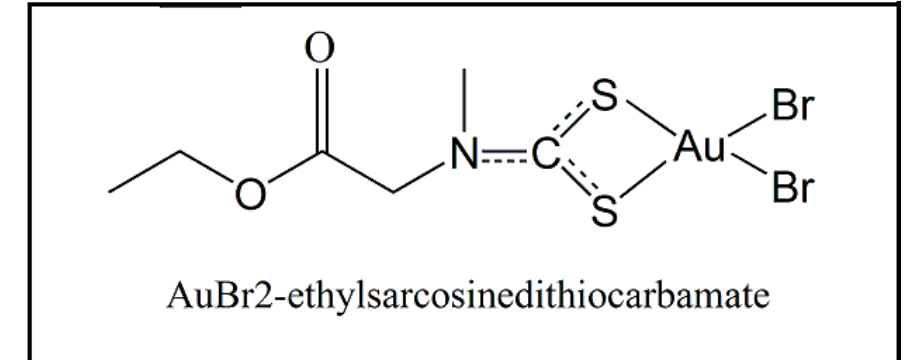
Figure 8. Synthetic dithiocarbamate derivatives bound to gold used as potential antiparasitic drugs against Trypanosoma brucei , Leishmania infantum , Trypanosoma cruzi and Plasmodium falciparum . The main biological activity attributed to this structure is related to its ability to induce oxidative stress and consequently parasite death [65].